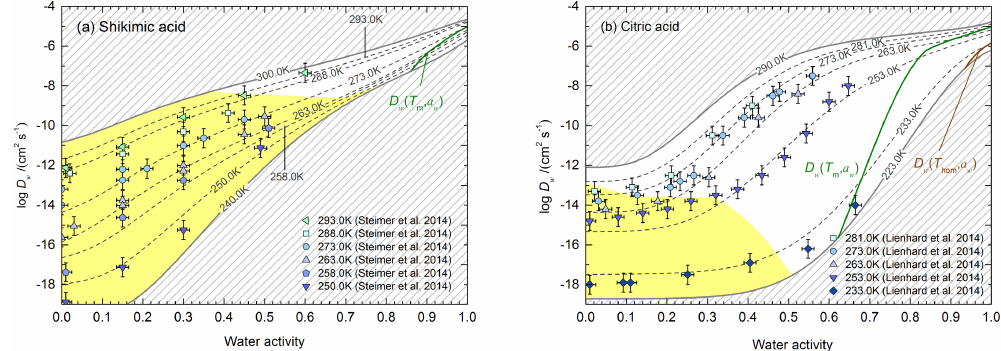
Figure A2. Same as Fig. 2 in the main text but for the previously measured model mixtures of (a) shikimic acid, O:C = 0.71, H:C = 1.43 and (b) citric acid, O:C = 1.17, H:C = 1.33.